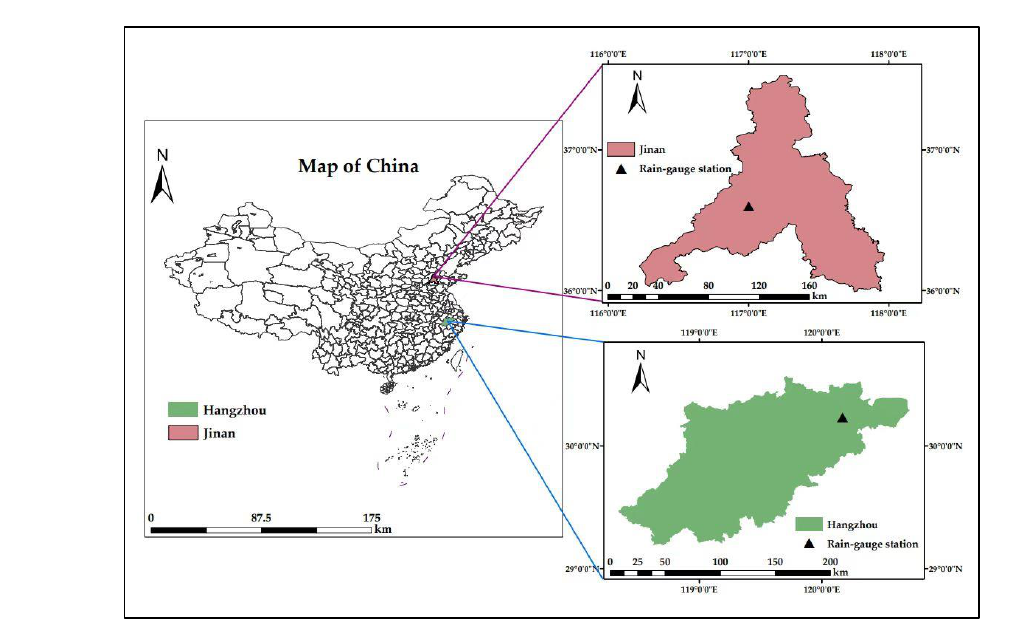
Figure 2. Location map of the two case study areas.